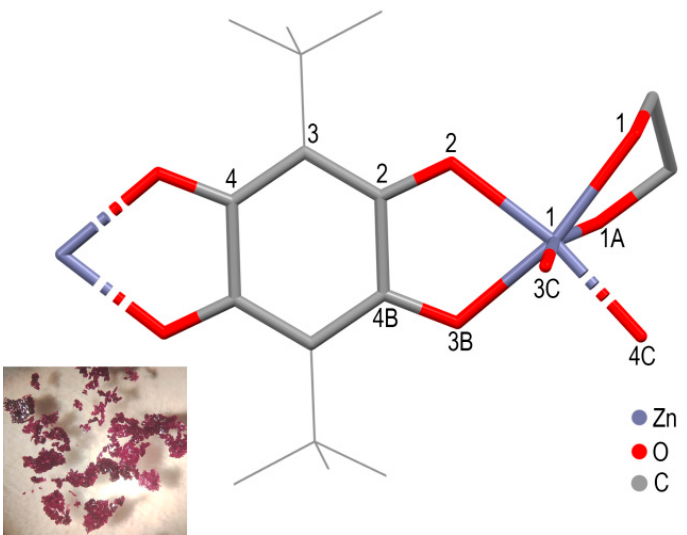
Figure 3. The view of molecular structure of the crystallographic unit in 1 . Photo of crystals is in the inset.